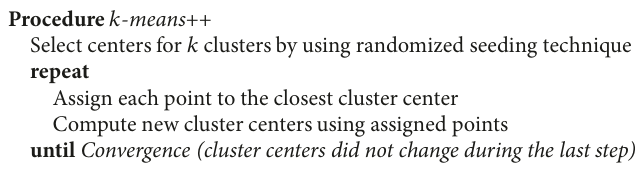
Algorithm 1: Outline of the 𝑘